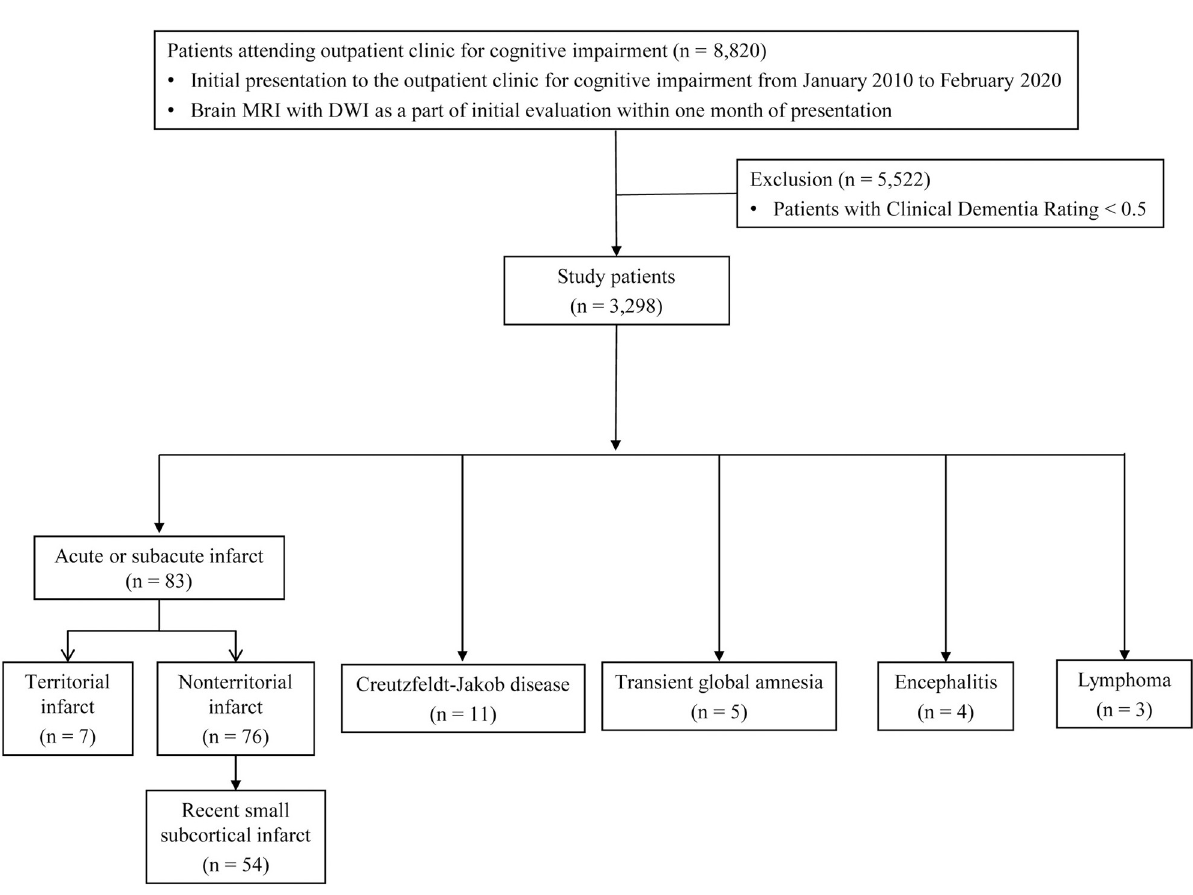
Fig 1. Patient flow diagram. DWI = diffusion-weighted imaging.